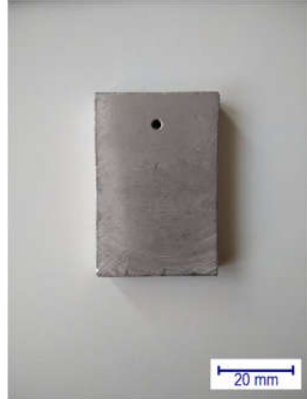
Figure 1. The untreated sample.